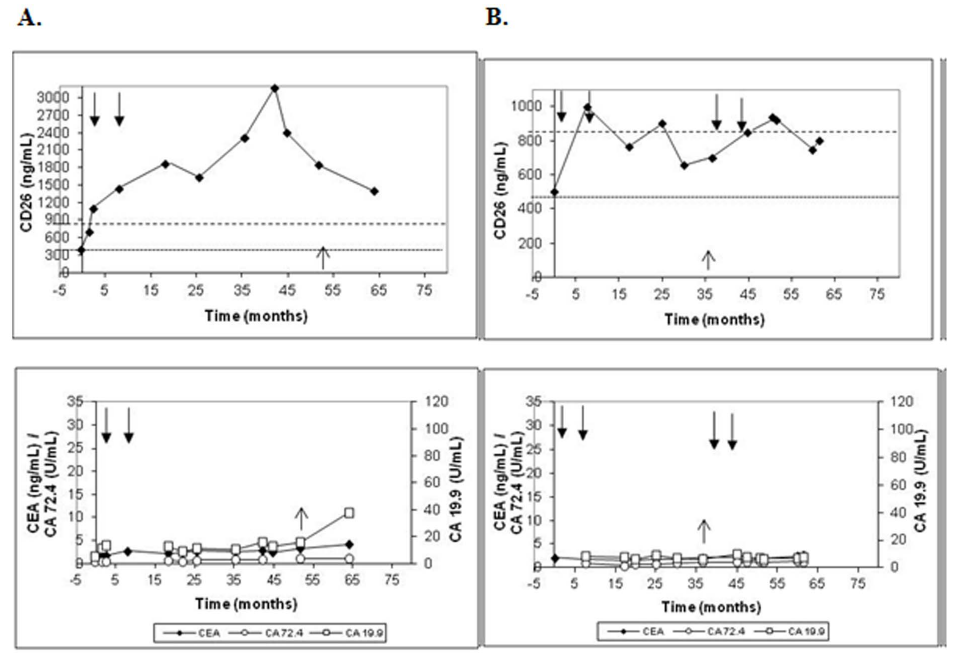
Figure 4. Levels of the sCD26, CEA, CA-19.9 and CA-72.4 in representative patients who developed hepatic (A; patient 34) and pulmonary (B; patient 39) metastases. Black arrows indicate beginning and end of chemotherapy cycles and the upwards arrow indicates